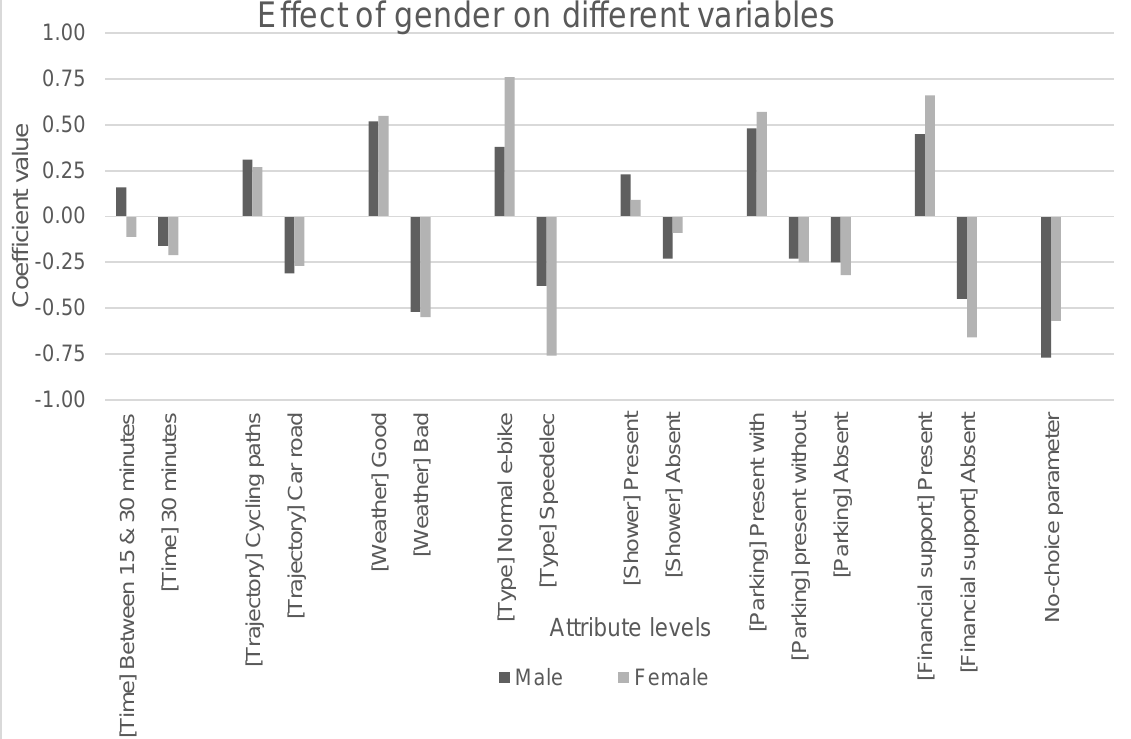
Figure 5. Effect of Gender on Different